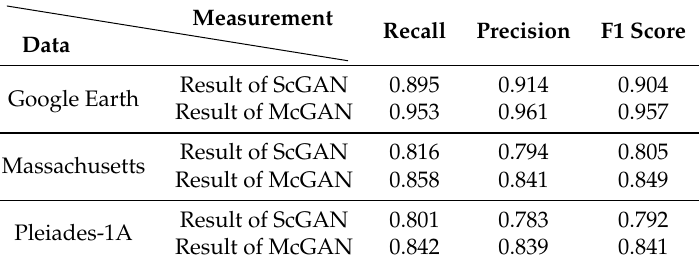
Figure 4. Visualized results of typical examples on Google Earth dataset: ( a ) original image; ( b ) result of ScGAN (without L t ); ( c ) result of McGAN; and ( d ) ground truth. Table 3. Quantitative statistics of McGAN on all the three